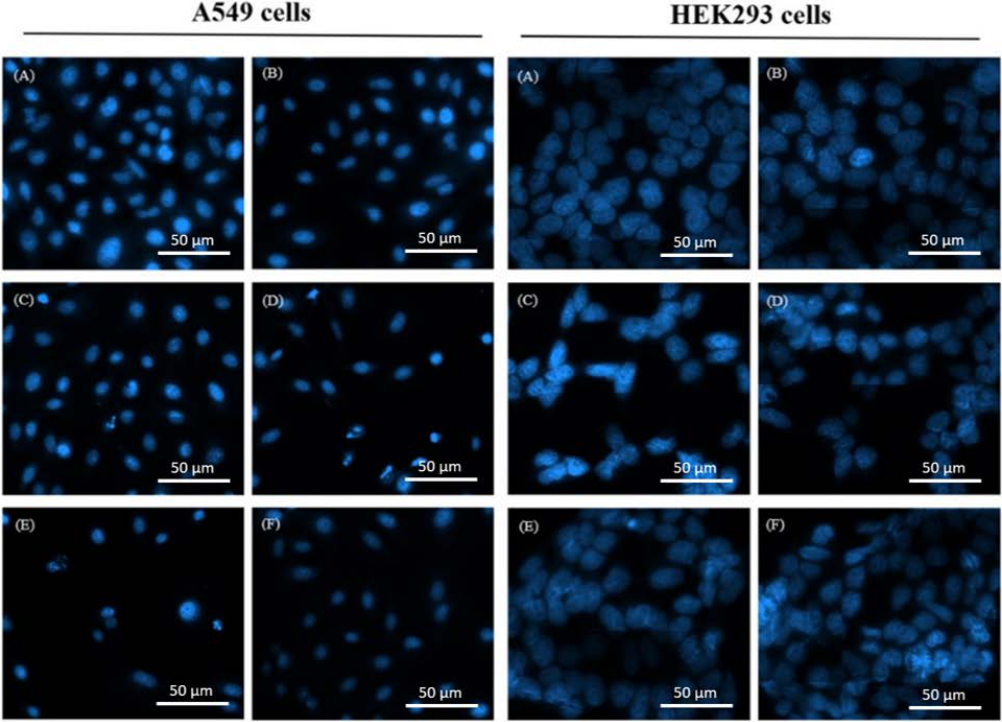
Figure 2. DAPI (4 ′ ,6-diamidino-2-phenylindole) fluorescence staining of DDP- and OGA-treated human lung cancer A549 cells and normal human embryonic kidney HEK293 cells. ( A ) Control, ( B ) OGA 24 h, ( C ) DDP 24 h, ( D ) DDP + OGA 24 h, ( E ) DDP 12 h + OGA 12 h, ( F ) OGA 12 h + DDP 12 h. Control: untreated A549 cells, DDP: cisplatin (2 μg/mL), OGA: oligogalacturonides (100 μg/mL).